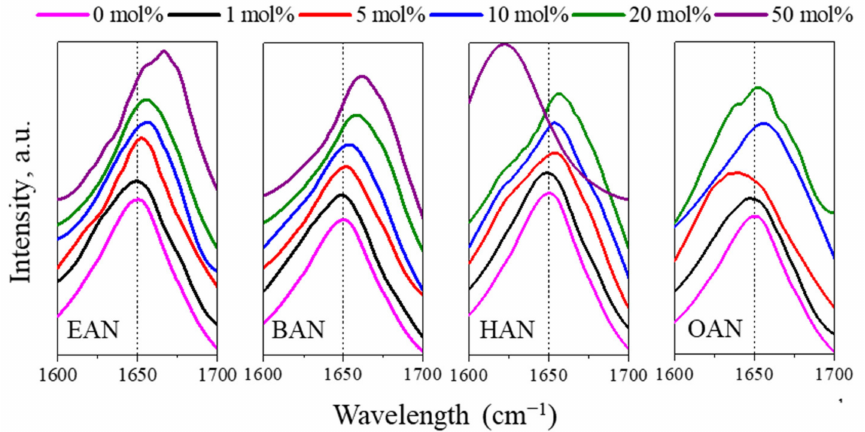
Figure 7. Normalised FTIR spectra of lysozyme in PIL-water mixtures (EAN, BAN, HAN and OAN). The control sample of lysozyme in a buffer solution at a pH value of 8 (0 mol% of PIL) is included for comparison in each series. The dashed line refers to the peak of the amide I band in